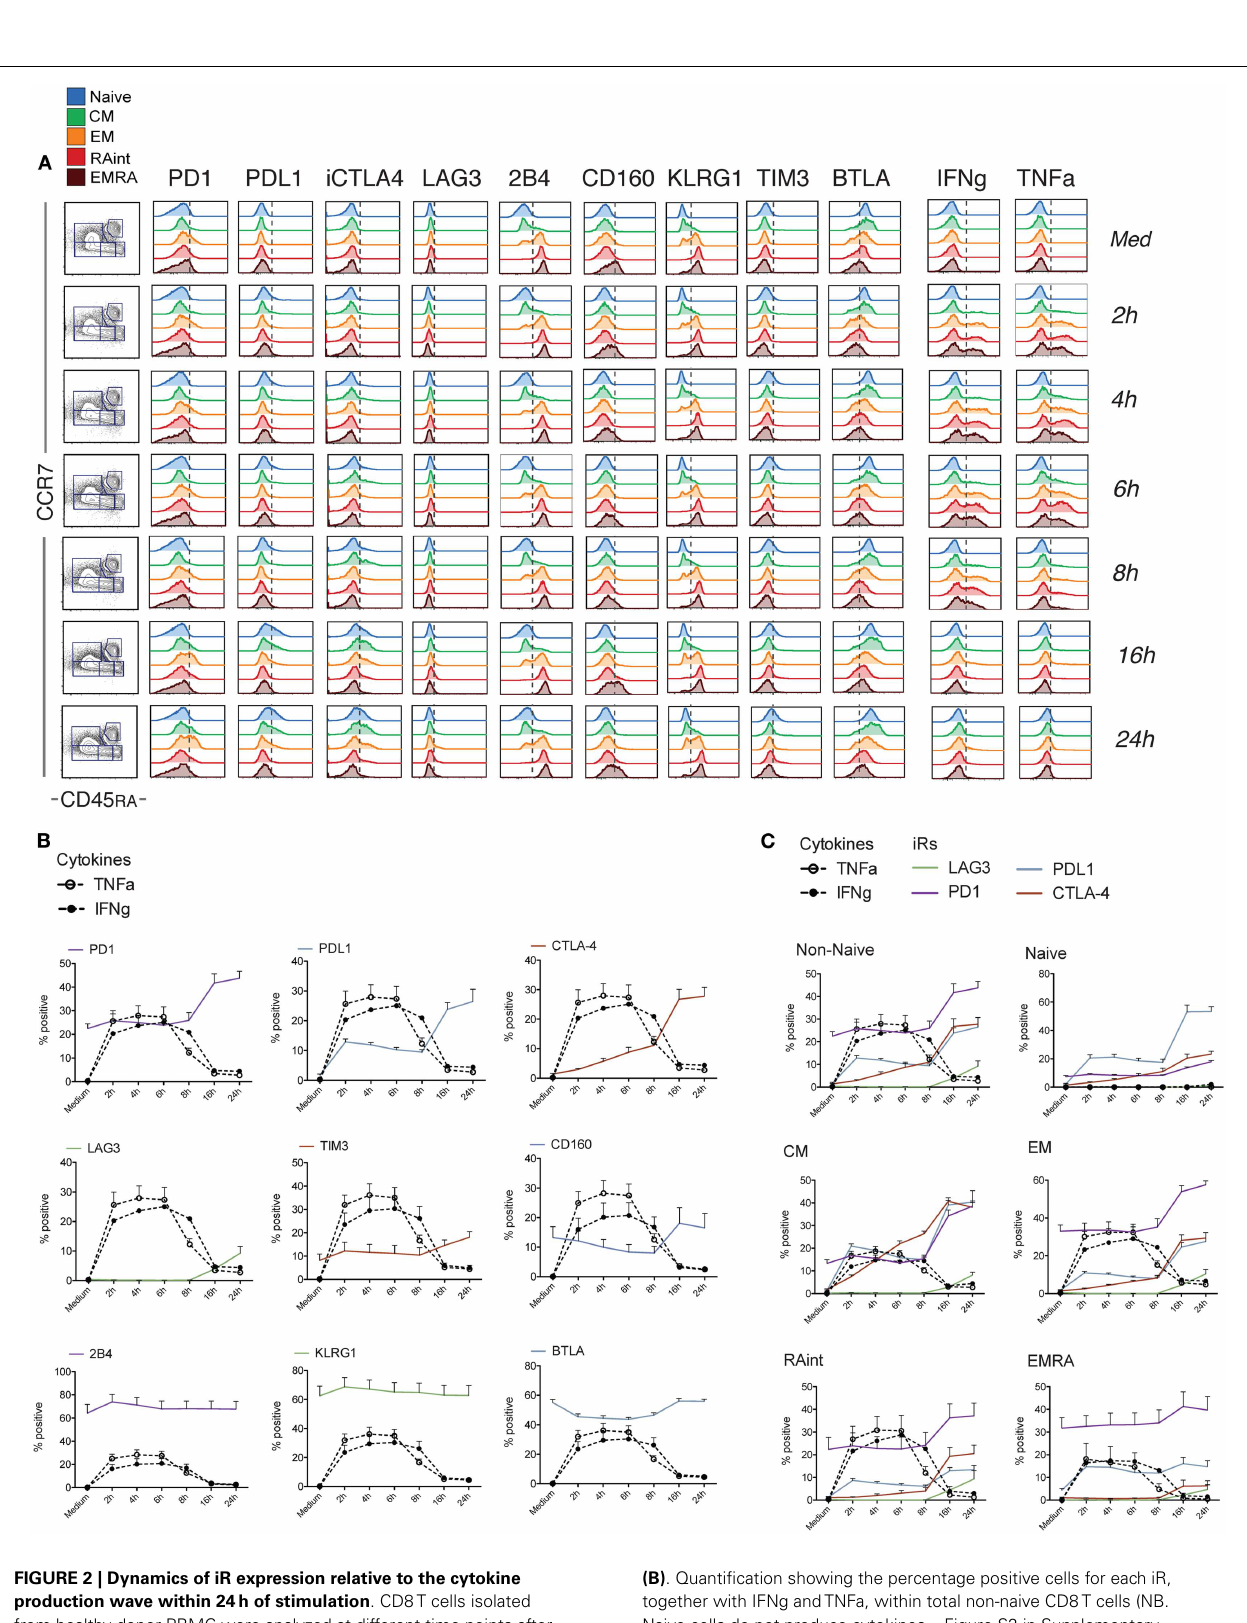
(B) . Quantification showing the percentage positive cells for each iR, together with IFNg andTNFa, within total non-naive CD8T cells (NB. Naive cells do not produce cytokines – Figure S2 in Supplementary Material). (C) . Grouped quantification for the iRs that showed up-regulation, in Non-Naive cells or the various differentiation subsets as